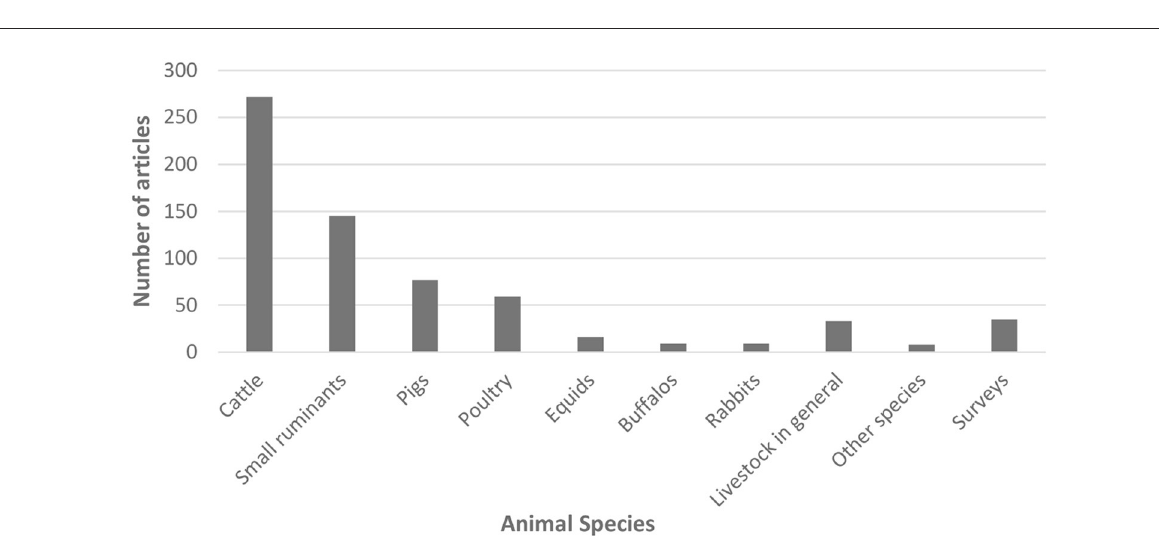
low compared to that of countries from North America